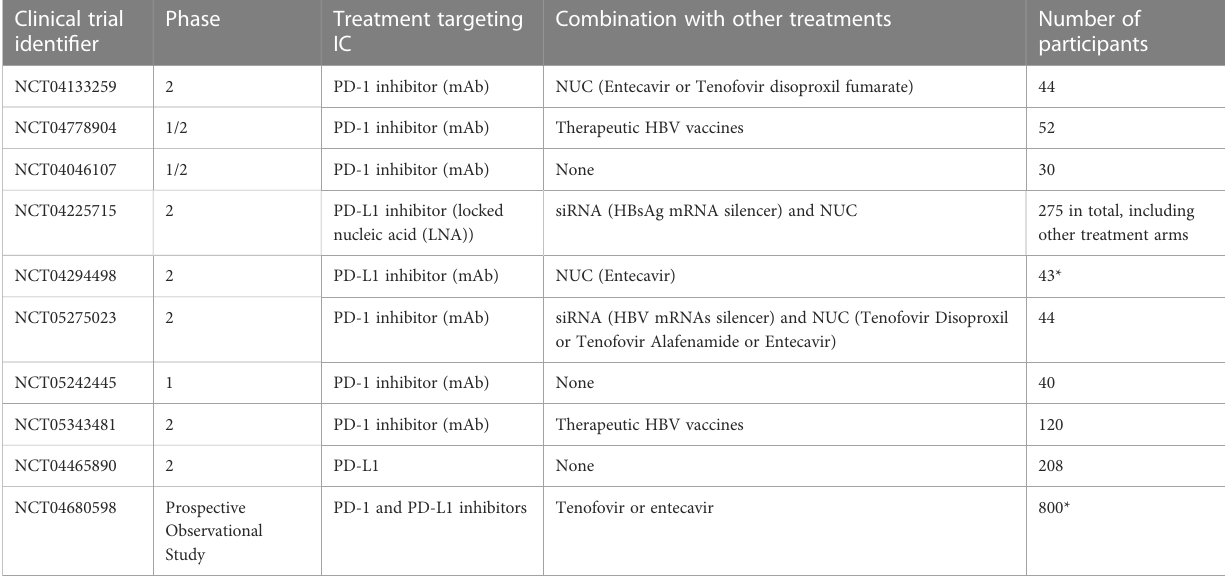
TABLE 3 Ongoing clinical trials in CHB patients involving checkpoint inhibitors. Clinical